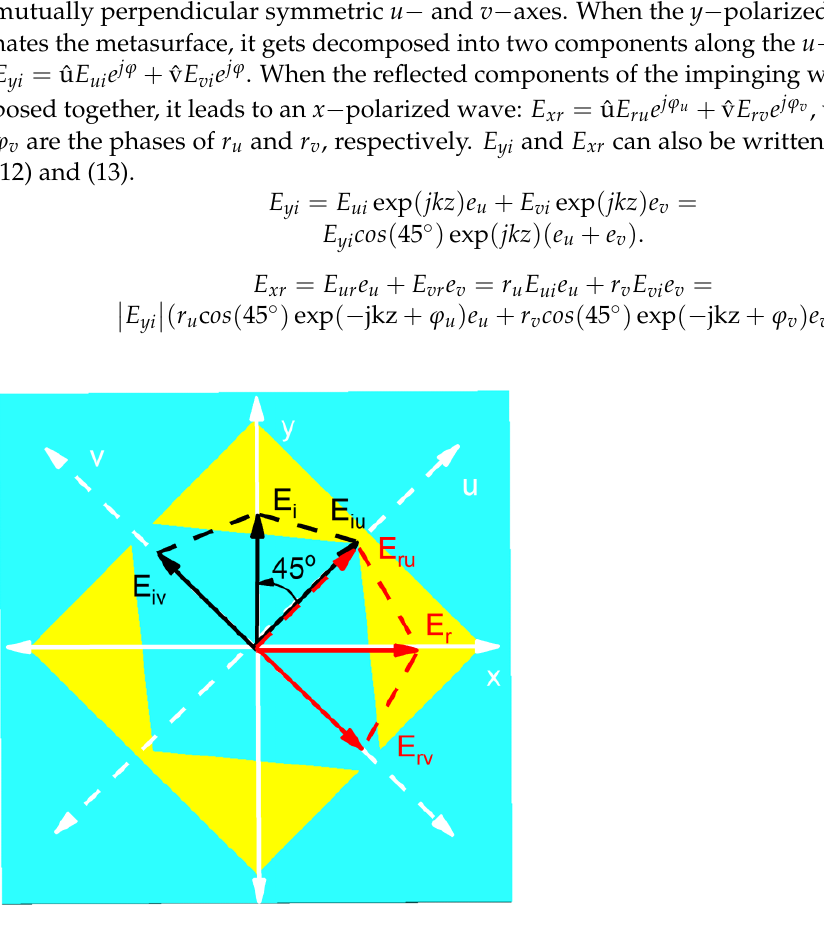
Figure 4. Illustration of the decomposition of orthogonal components u and v in reflection mode.